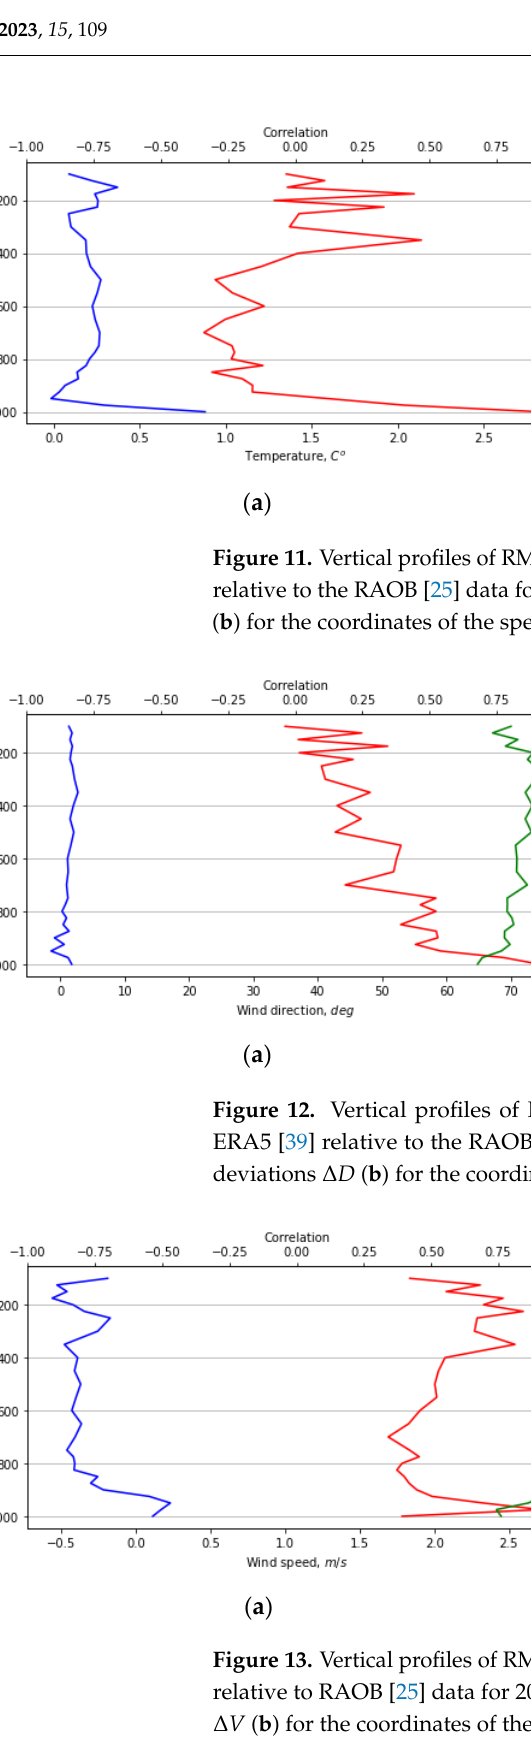
Figure 10. Vertical profiles of RMSE, Bias, and Corr for the values of relative humidity based on